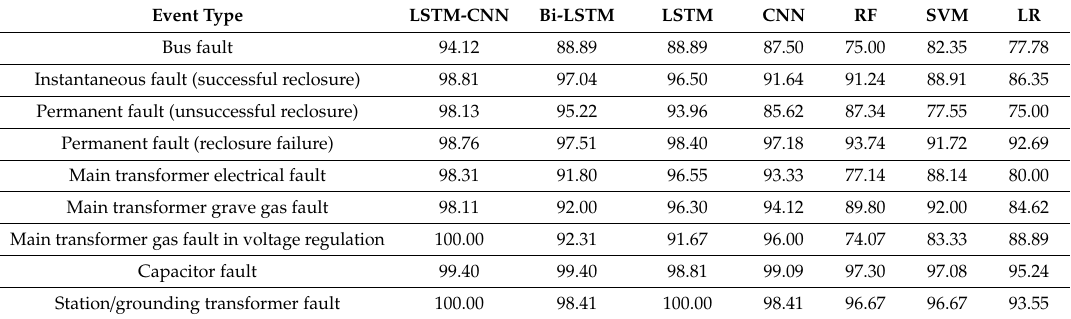
Table 11. Comparison of F 1 -score of this model with other